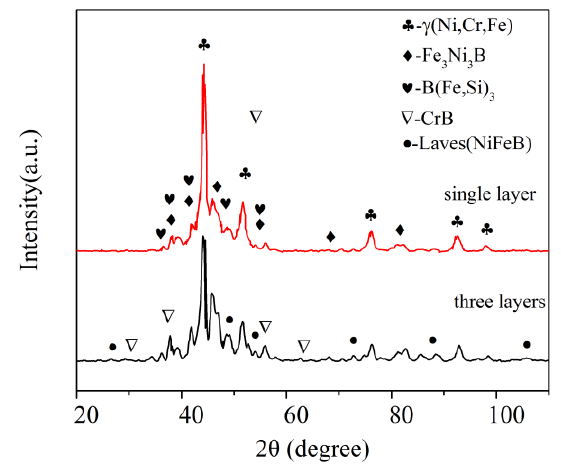
Figure 5. XRD patterns of the laser cladded monolayer and trilayers Ni-based coatings.